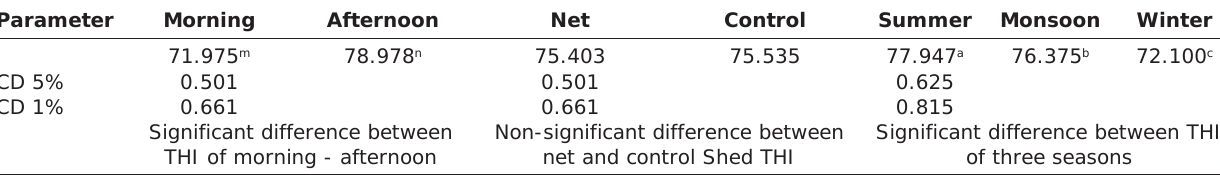
Table-4: Comparison of THI estimated in the net shed and control shed during the three seasons. Parameter